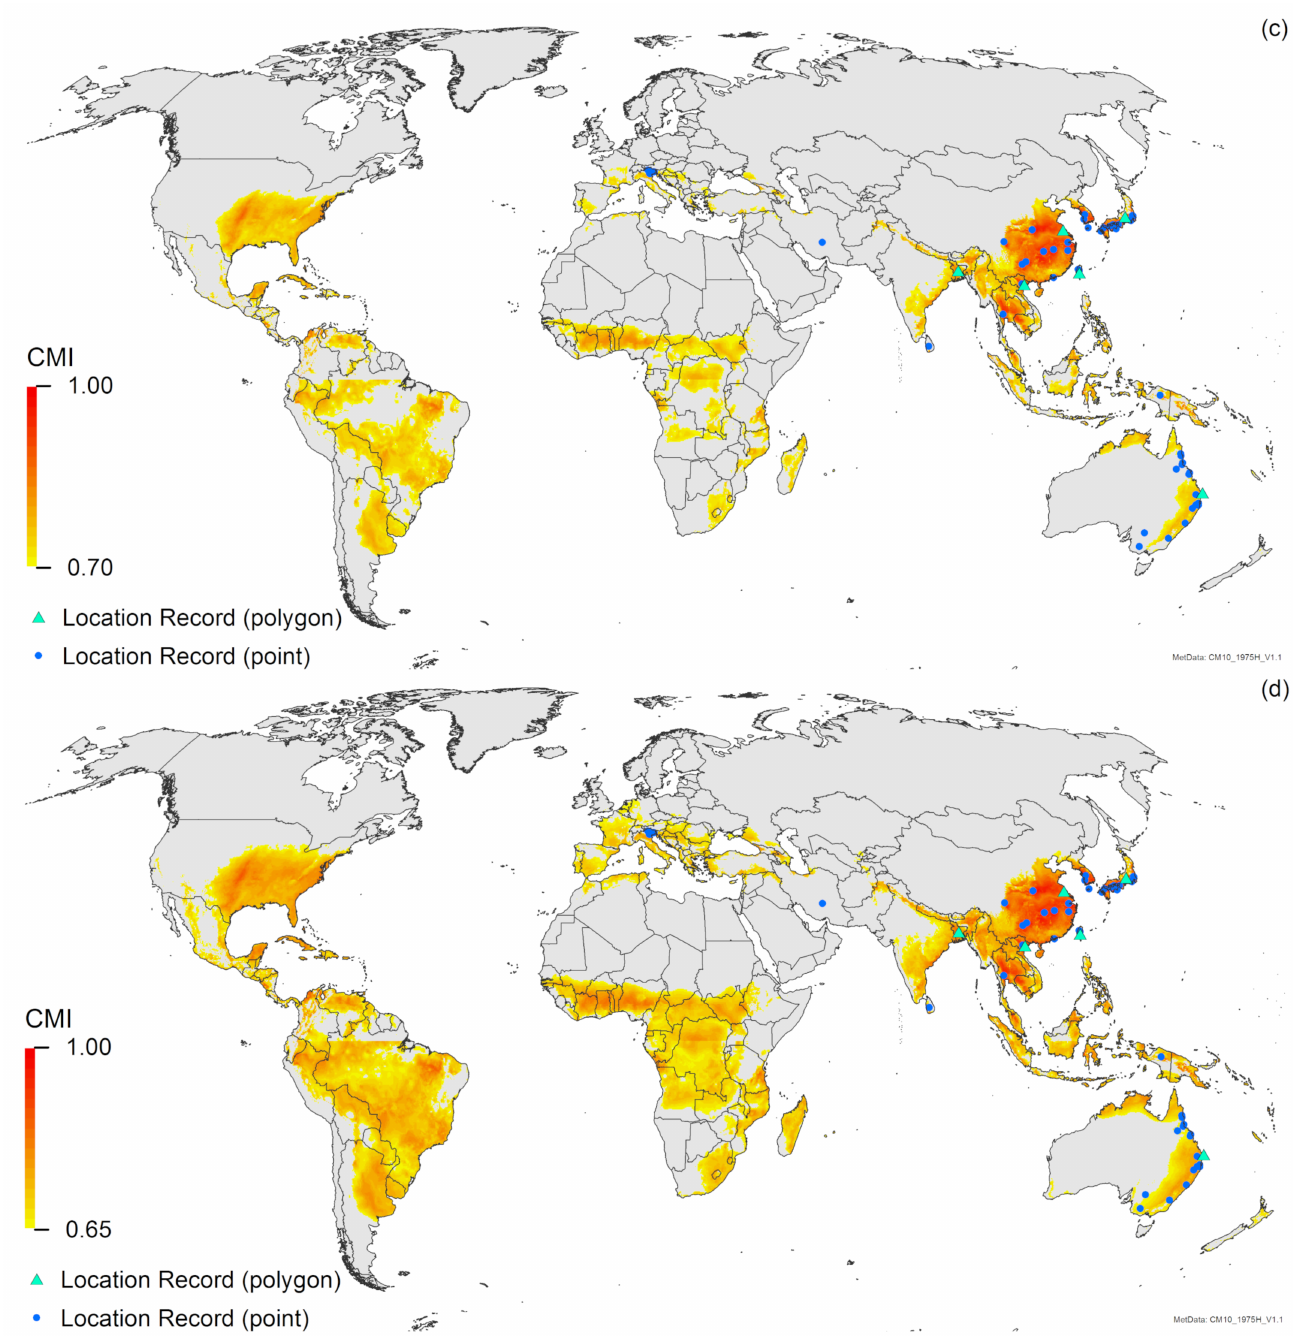
Figure A3. Composite map of the maximum Climate Match Index (CMI) between native locations and the rest of the world: ( a ) Regional Match Climate (RMC) using minimum and maximum temperature and soil moisture, CMI > 0.70; ( b ) RMC using minimum and maximum temperature and soil moisture, CMI > 0.55; ( c ) RMC using minimum and maximum temperature, rainfall amount and pattern, CMI > 0.70; ( d ) RMC using minimum and maximum temperature, rainfall amount and pattern, CMI > 0.65. Location records are for Trissolcus mitsukurii : circles are point location records; triangles are polygon